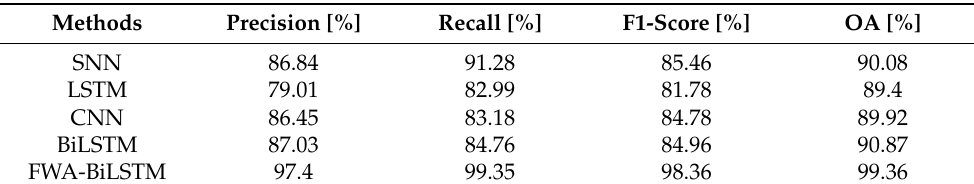
Table 5. Performance of classifier without attention layer on SVD dataset.